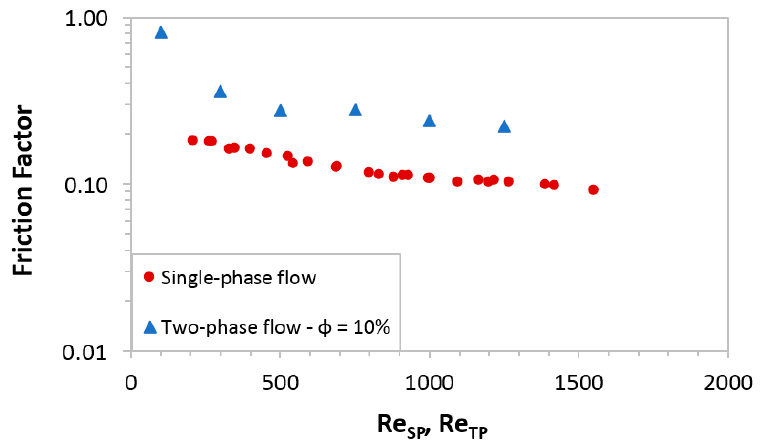
Figure 12. Friction factor for single phase and two-phase flow versus Reynolds number.